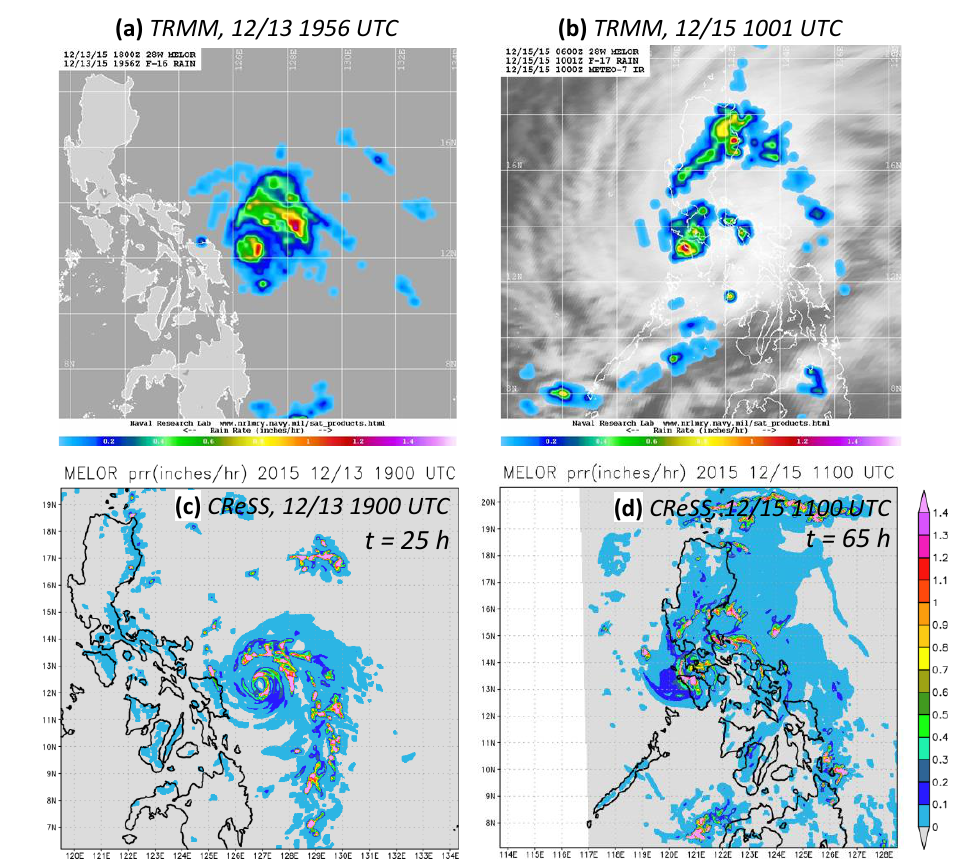
Figure 12. As in Figure 7, except for TRMM rainrate (inch h −1 ) of TY Melor (2015) at ( a ) 1956 UTC 13 (no cloud imagery from stationary satellite) and ( b ) 1001 UTC 15 December (source: NRL), and model rainrate (inch h −1 ) valid at ( c ) 1900 UTC 13 and ( d ) 1100 UTC 15 December from the forecast initialized at 1800 UTC 12 December 2015.